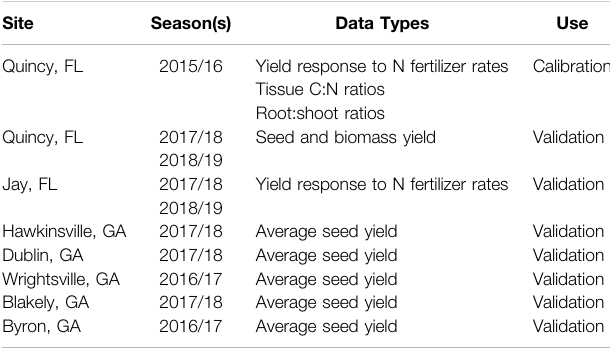
TABLE 1 | Field data sources used for DayCent model calibration and